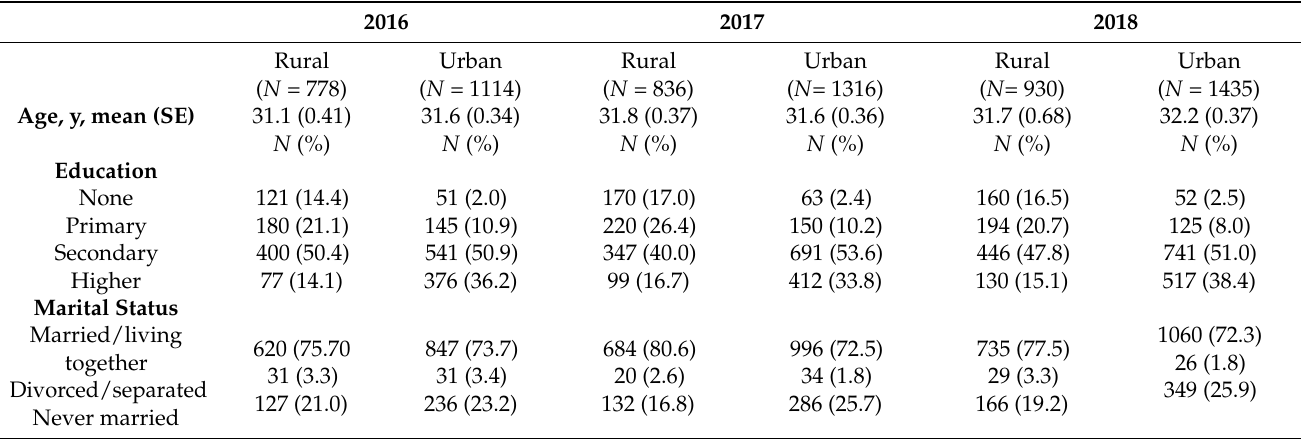
Table 1. Characteristics of respondents interviewed by rural–urban residence PMA2020, 2016–2018 ( n =